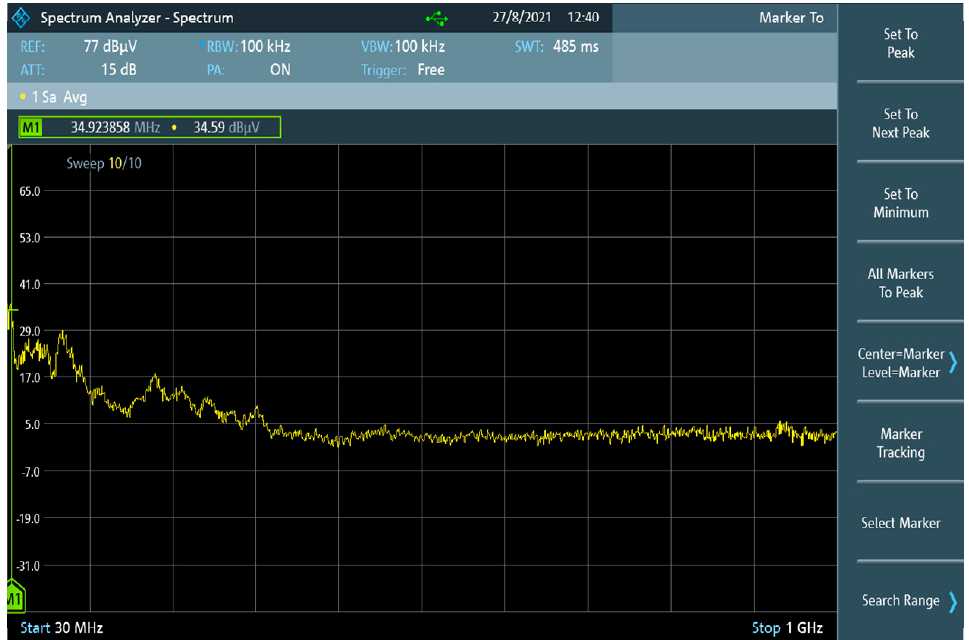
Figure 13. EMI measurement spectrogram of Block A1.